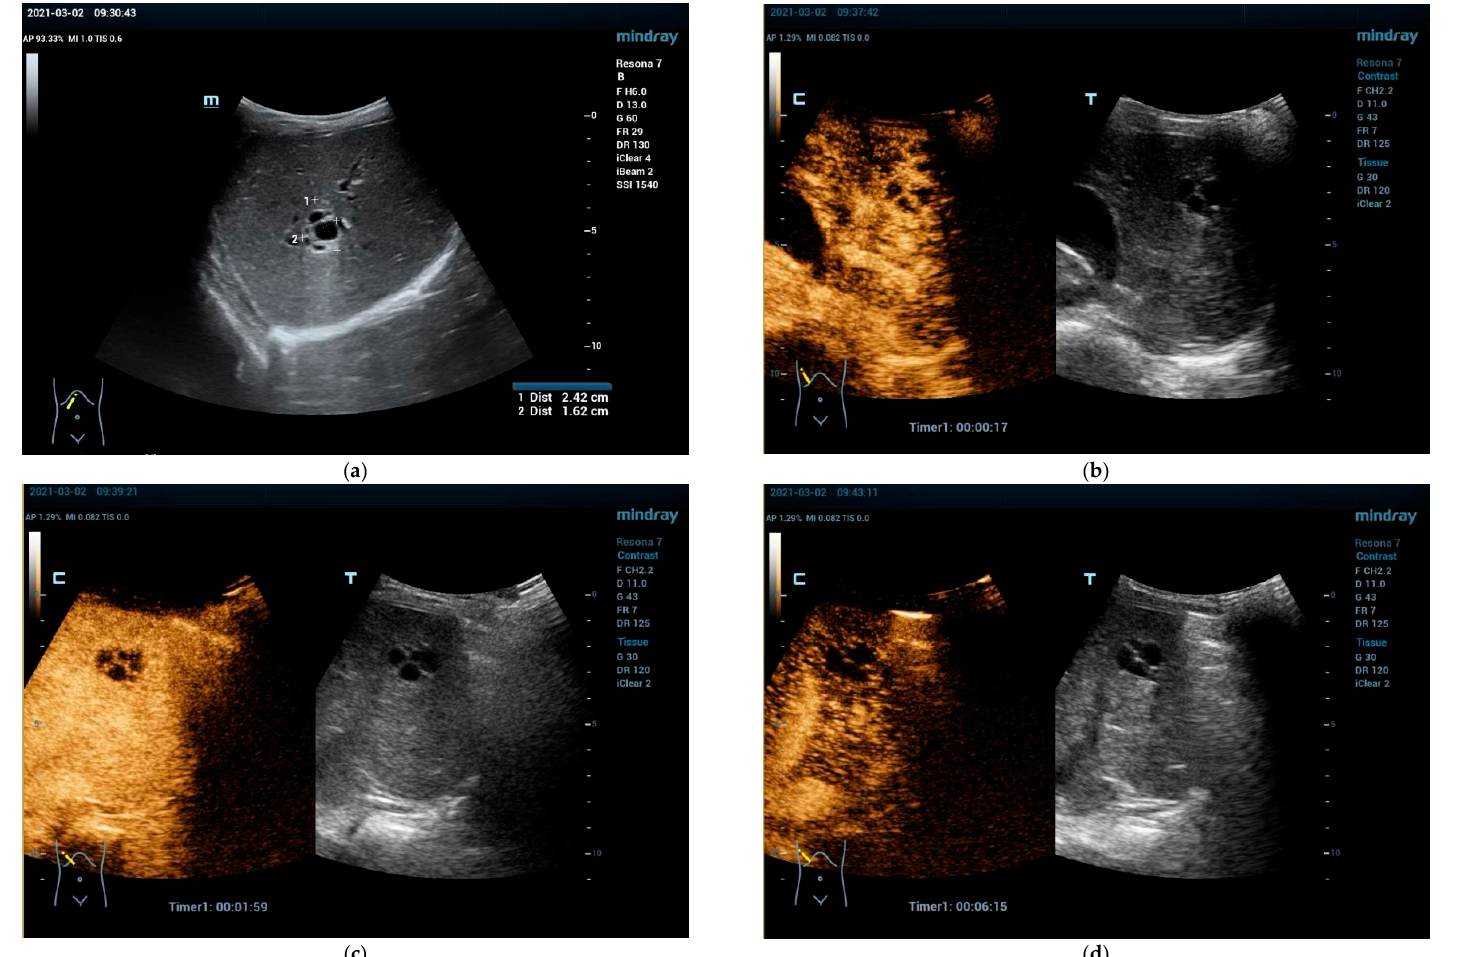
Figure 3. 9-year-old girl with incidentally detected liver cyst. B-mode—24 mm × 16 mm septated cyst with echogenic rim in the central part of the liver ( a ). Contrast-enhanced ultrasound in the arterial phase shows only rim and septal enhancement without any flow in the cystic parts ( b ). The same pattern remains in the portal venous ( c ) and late ( d ) phases and no washout in the rim or septa. No treatment nor other investigation suggested (SC5-1U transducer).